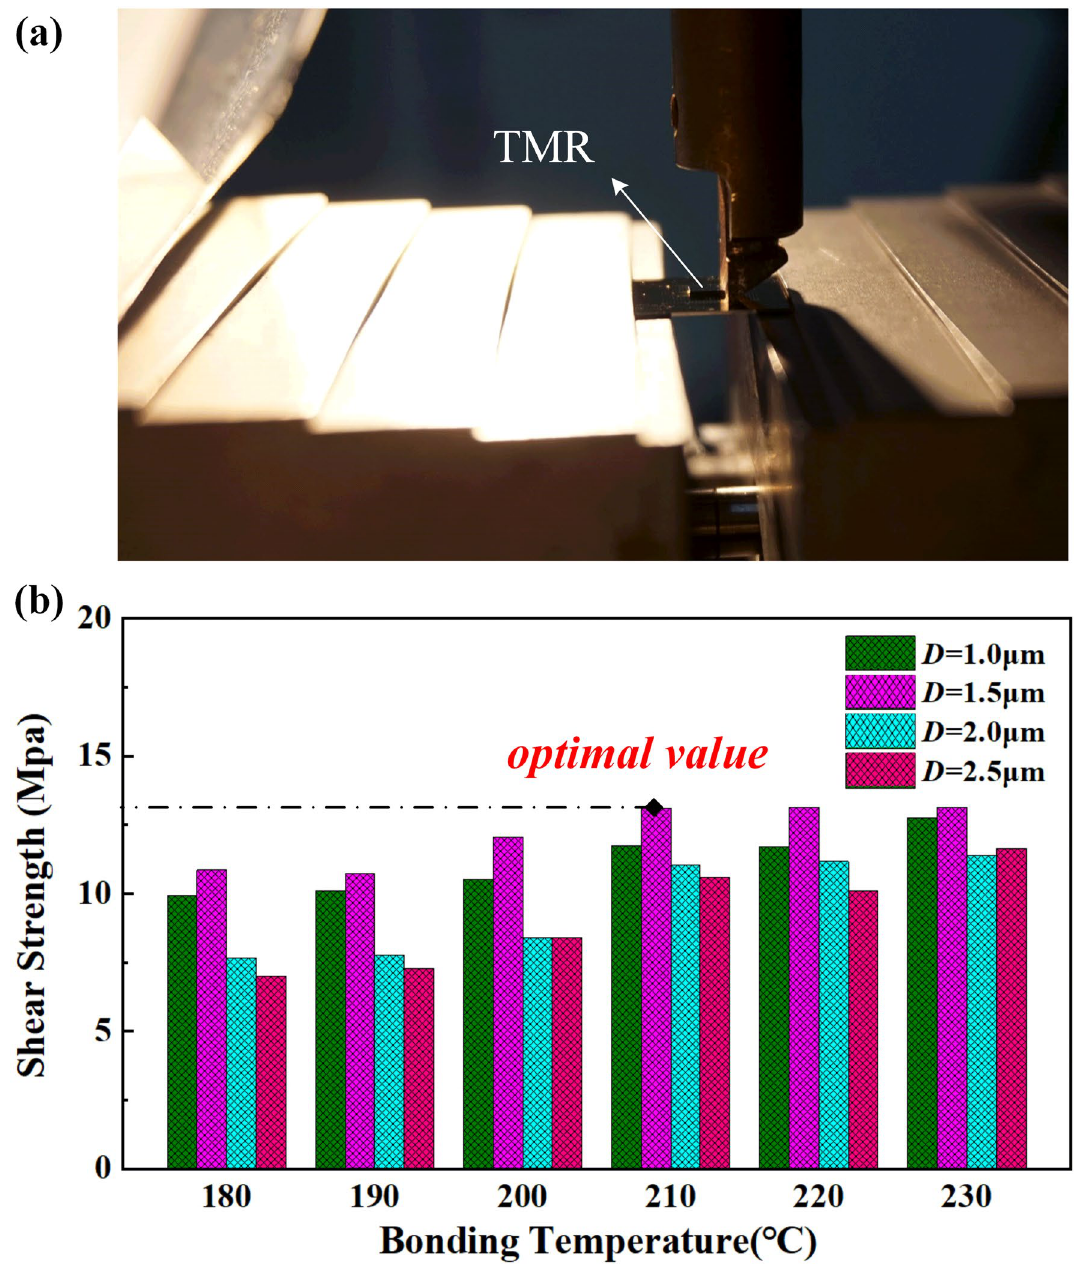
Figure 5. Shear test results. ( a ) Illustration of shear test configuration. ( b ) The shear strength as function of bonding temperature with different In thickness D Fig. 5a. At a shear test pressure of 20 MPa and bonding time of 5 min, it’s obvious that the increment in shear strength is significant while the bonding temperature changes from 453 to 503 K (180–230 ◦ C ). There exists an optimal In thickness, as shown in Fig. 5b, the shear strength of the bonding layer is up to more than 10 MPa with the thickness of 1.5 µ m. According to the remanence temperature coefficient, the magnetism of the magnetic material in the TMR decreases with increasing temperature which directly affects the TMR performance. It will mostly recover after cooling when the temperature rises within certain temperature range. It is experimentally demonstrated that the TMR will cause irreversible process when the temperature increases further more than 493 K ( 220 ◦ C ) and will damage as higher temperature, especially larger than 523 K (250 ◦ C ) . According to the above analysis of shear strength dependence, Au-In bonding experiment is performed at a lower temperature 483 K ( 210 ◦ C ) with the thickness of 1.5 µ m. Figure 6 shows the SEM/EDS image of fracture surface of bonded sample. We observe three different positions in fracture surface, as shown in Fig. 6a–c. The positions of this fracture correspond to the bond interface between the substrate and the compound layer, indicating that rupture occurs at adhesive layer rather than cohesive fracture, compared with the other fracture surface shown in Fig. 6d. From the Fig. 6a,c, two Au-In intermetallic